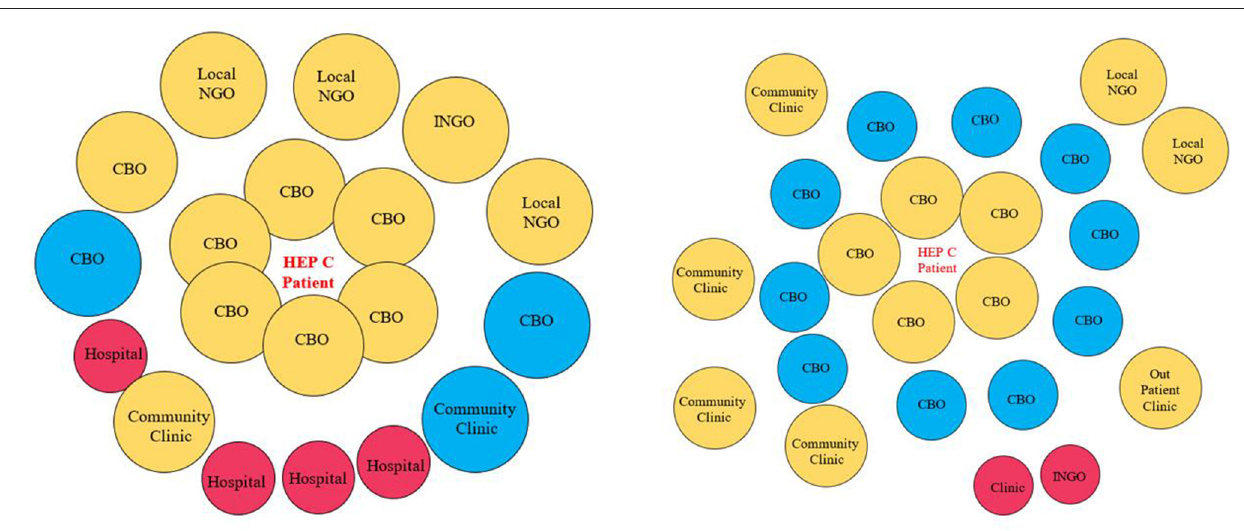
FIGURE 4 | Venn diagrams from CBO-level AG meeting. The circle size implies perceived level of influence from the stakeholder to the center. The distance from the circle to the center point implies access level from the stakeholder to the center. CBO, Community Based Organization; INGO, International Non-Government Organization; Local NGO, Local Non-Government